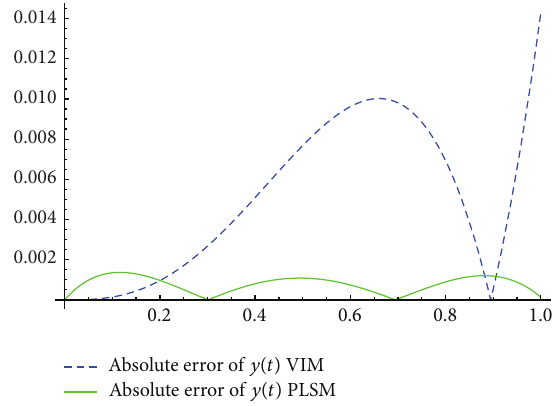
Figure6:Theabsoluteerrorscorrespondingto 𝑦(𝑡) forthecase 𝛼 1 = = 1 . 𝛼 2